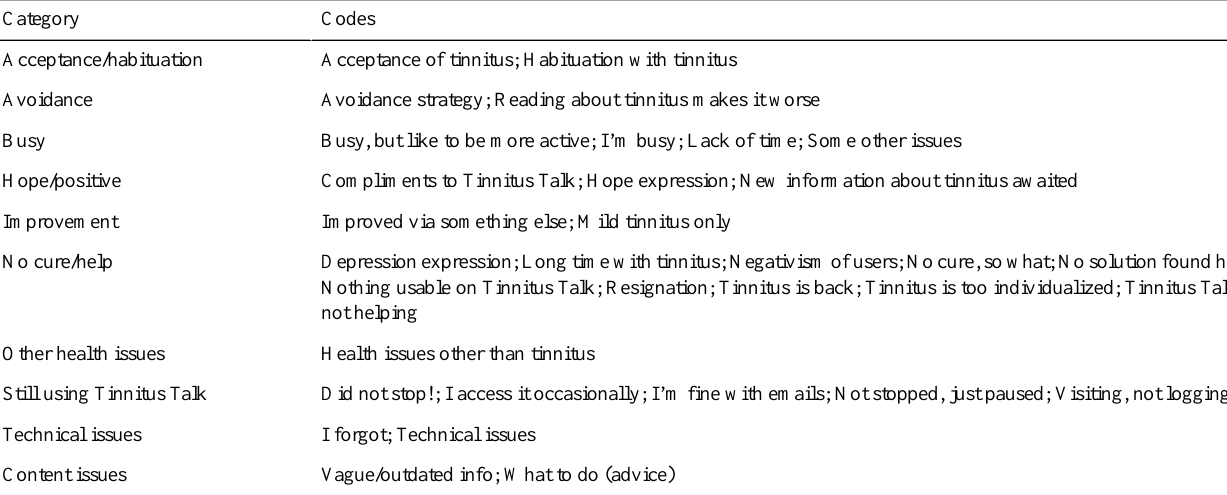
Table 3. Categories and codes for other reasons (R9 in Table 2).